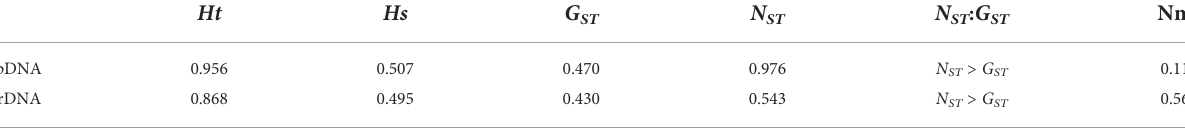
TABLE 5 The genetic parameters and gene fl ow of cpDNA and nrDNA.